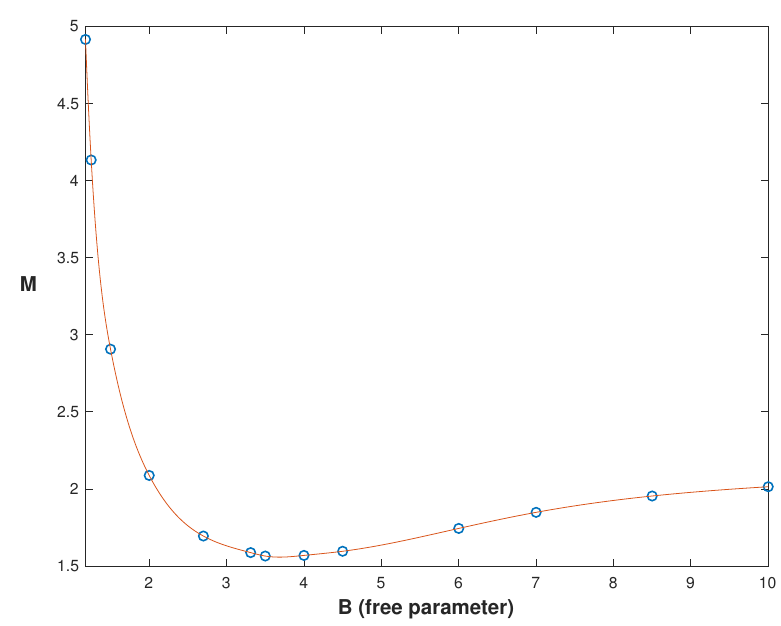
Figure 6. Proper energy (mass) M against the free parameter B .